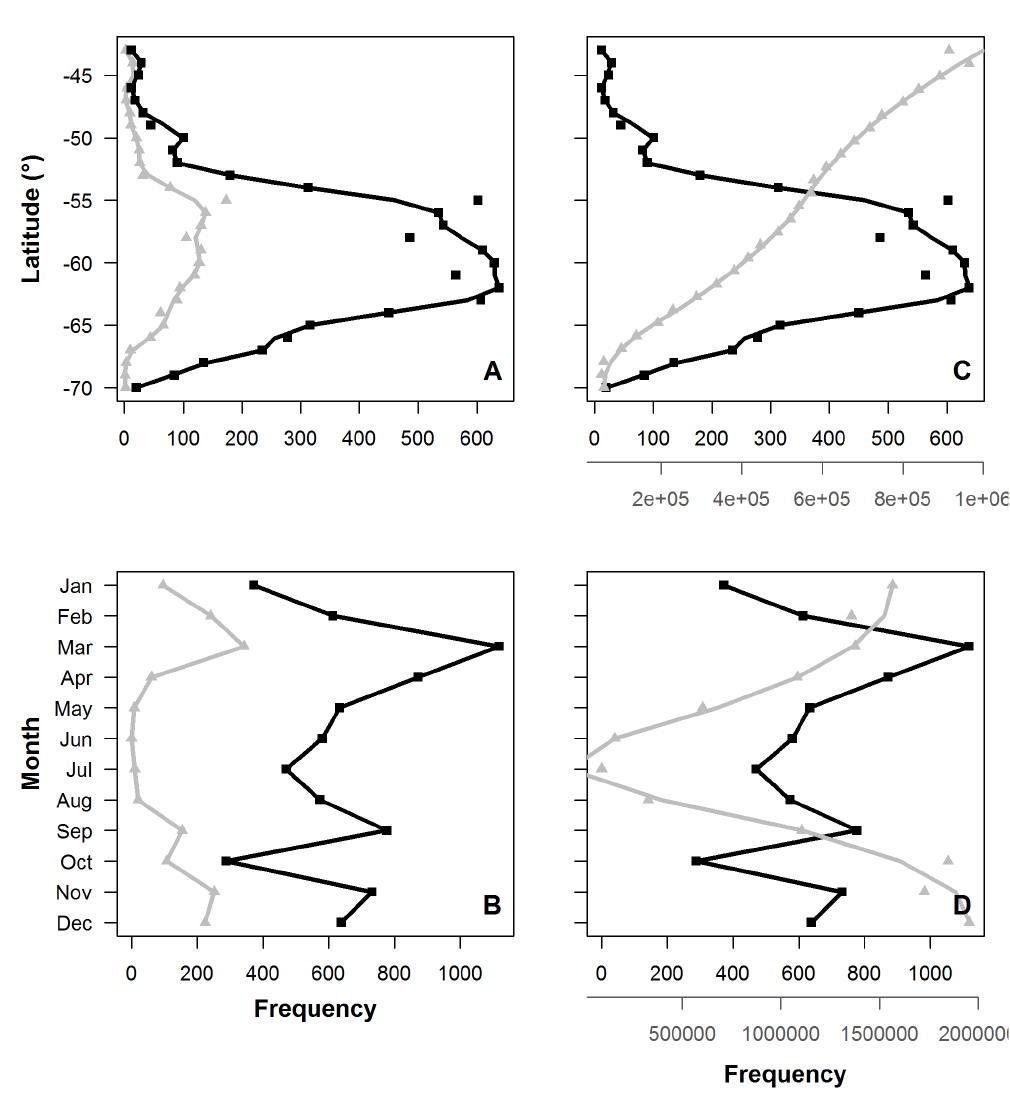
Figure 8. Data frequency coverage of chl-a * and TDRL chl { : data coverage of the study region is shown by ( A ) latitude (at 1 u increments) and ( B ) months (between 1999 and 2005). Black represents TDRL chl coverage and grey represents chl-a coverage. Lines represent a loess fit. * chl-a data. { Light-based phytoplankton index calculated from TDLR data.